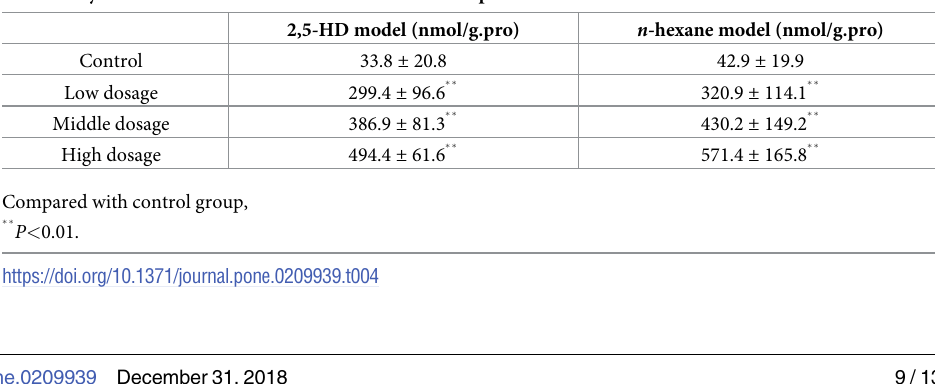
Table 4. Pyrrole adducts concentration in hair on the